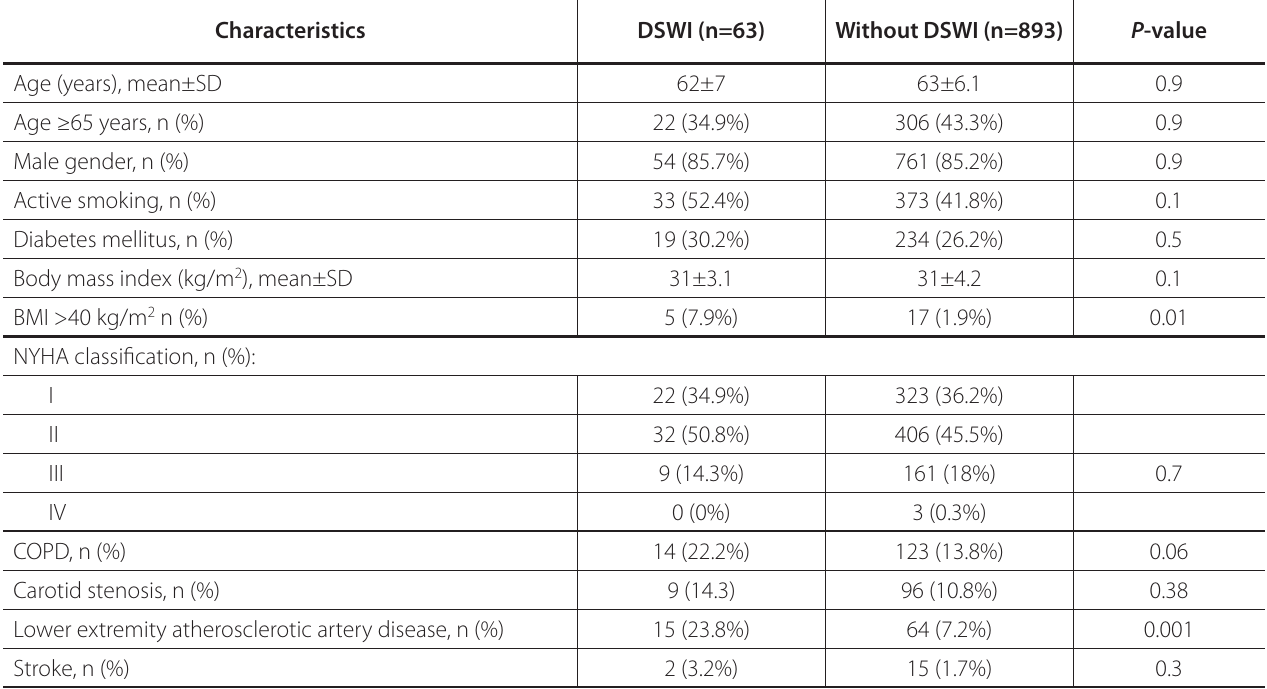
Table 1 . Preoperative risk factors for sternal infection. Characteristics